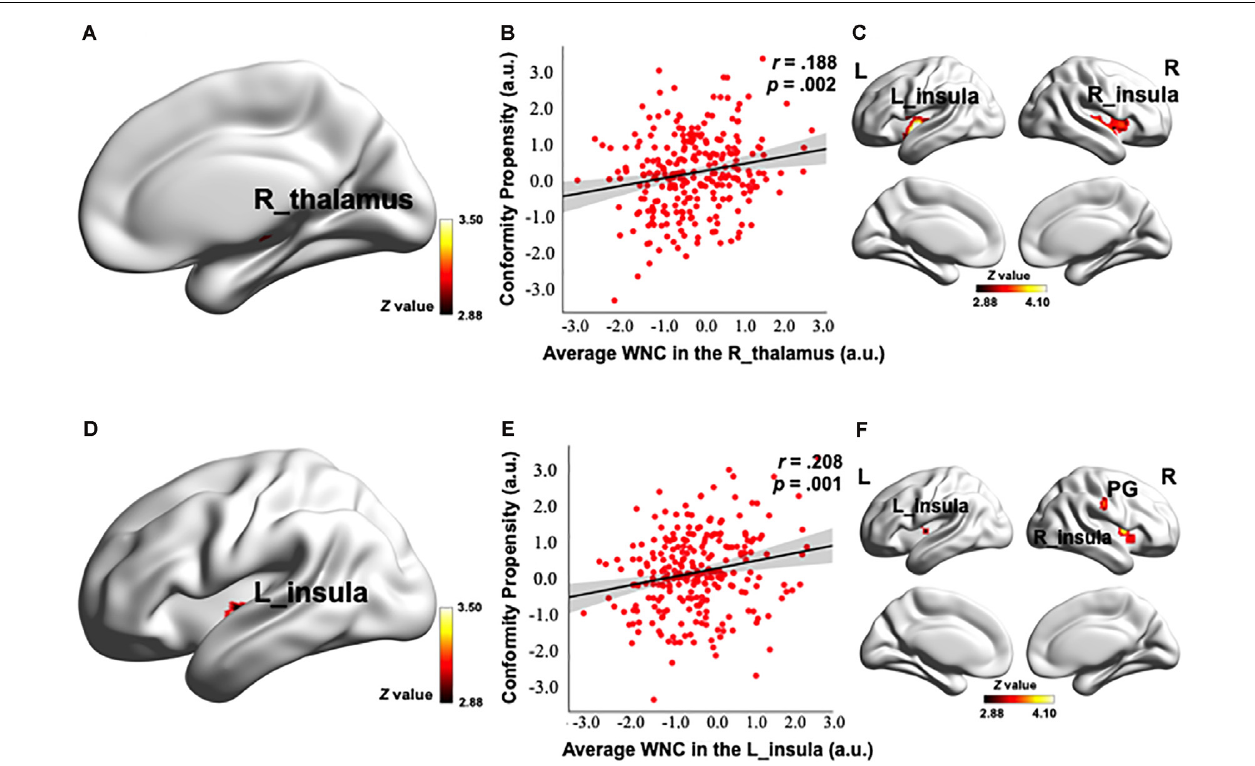
FIGURE 2 | Correlation between the PN WNC and conformity. The PN WNC in the R_thalamus (38 voxels, voxel-level p < 0.002, cluster-level p < 0.05, corrected) and L_insula (44 voxels, voxel-level p < 0.002, cluster-level p < 0.05, corrected) was positively correlated with conformity (A,D) . The scatter plots are shown just for illustration and visualization of the partial correlation (controlling for gender and head motion) between the PN WNC in the R_thalamus, L_insula, and conformity (B,E) . Correlation between seed-based functional connectivity (FC) and conformity is shown in Panels (C,F) . (C) The FC between the R_thalamus seed and the clusters in the bilateral insula was positively correlated with conformity. (F) The FC between the L_insula seed and the clusters in the bilateral insula and postcentral gyrus (PG) was positively correlated with conformity. To better visualize the location of the significant clusters, the boundary of the clusters are shown with a red contour. L, left; R, right; a.u., arbitrary units. The visualization was provided by BrainNet Viewer